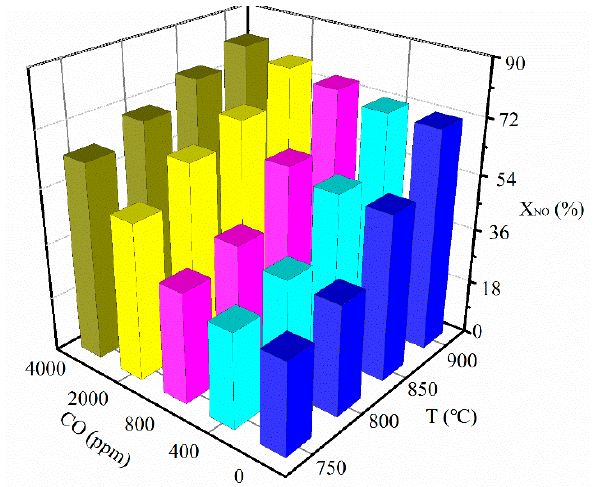
ff ect of reaction temperature on NO reduction with rice husk Figure 4. Effect of reaction temperature on NO reduction with rice husk char. Figure 4. E